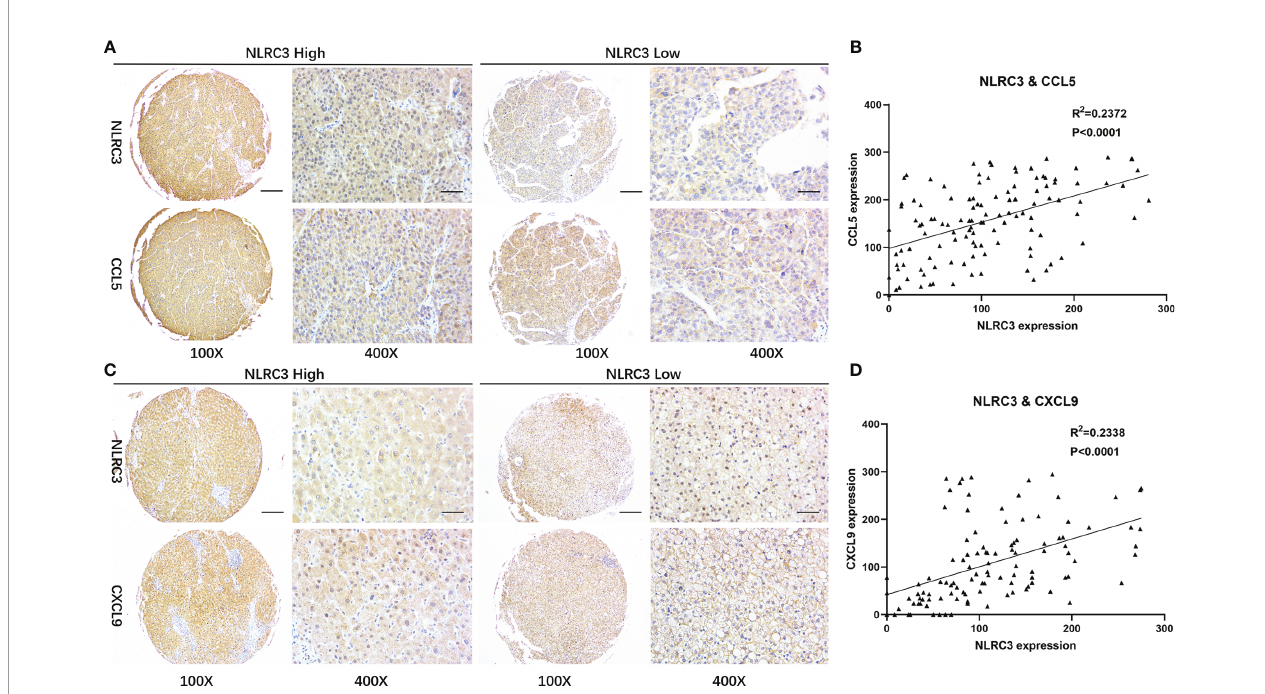
FIGURE 5 | Correlations between NLRC3 and T-cell recruiting chemokines. (A) Representative images of NLRC3 and CXCL9 expression in HCC detected by IHC on the TMAs (magni fi cation 40×, scale bar=500 m m. boxed area 400×, scale bar=50 m m). (B) NLRC3 expression in HCC tissue positively correlated with CCL5 expression ( P <0.0001), data were analyzed by Pearson ’ s R 2 correlation test. (C) Expressions of NLRC3 and CXCL9 in HCC (magni fi cation 40×, scale bar=500 m m. boxed area 400×, scale bar=50 m m). (D) NLRC3 expression in HCC tissue positively correlated with CXCL9 expression ( P <0.0001), data were analyzed by Pearson ’ s R 2 correlation